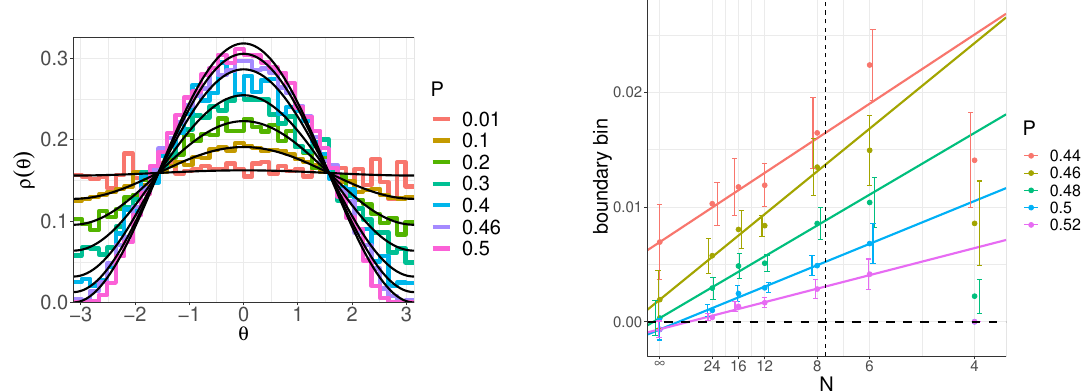
Figure 16. Full BMN model: [Left] Histogram of the Polyakov line phases in the interval [ P − ∆ P, P + ∆ P ] , for ∆ P = 0 . 01 and various values of P , for µ = 2 . 0 , T = 0 . 543 (close to T size N = 32 , and lattice size L = 12 . The large µ behavior ρ ( θ ) = 1+2 P cos θ clear deviation is observed close to P = 0 . 5 . It appears that the GWW-point is between P = 0 . 4 and P = 0 . 46 . The Myers term was not constrained in this simulation. [Right] Large N extrapolation of the size of the boundary bin for L = 12 and ∆ P = 0 . 01 . The GWW transition is seen to take place around P = 0 . 46 . Only data points left of the dashed vertical line were included in the linear